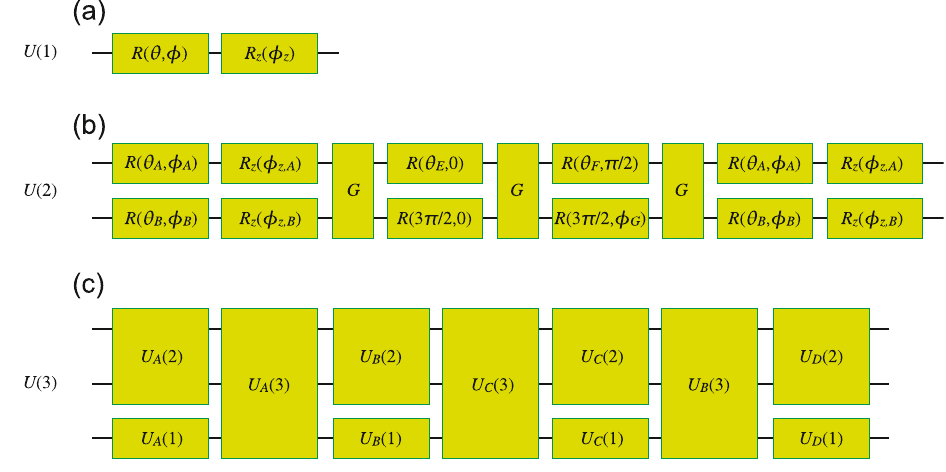
Figure 5. Universal quantum circuits for ( a ) one, ( b ) two and ( c ) three